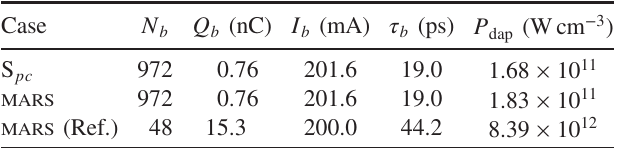
TABLE IX. Absorbed power density comparing the S pc - derived value for the average of the experimental cases at 200 mA with that from the MARS result and the reference MARS timing-mode bunch for